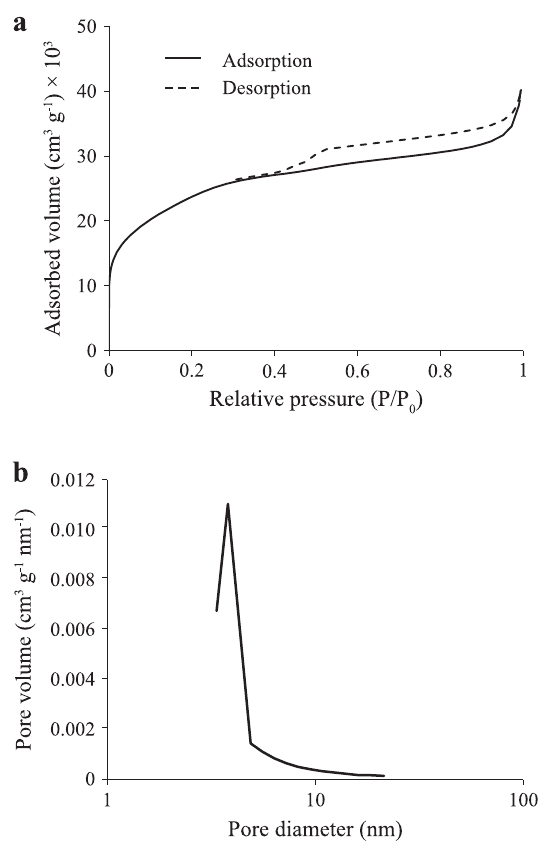
Fig. 8 Adsorption-desorption curves (a) and pore size distri- bution (b) of the synthesized